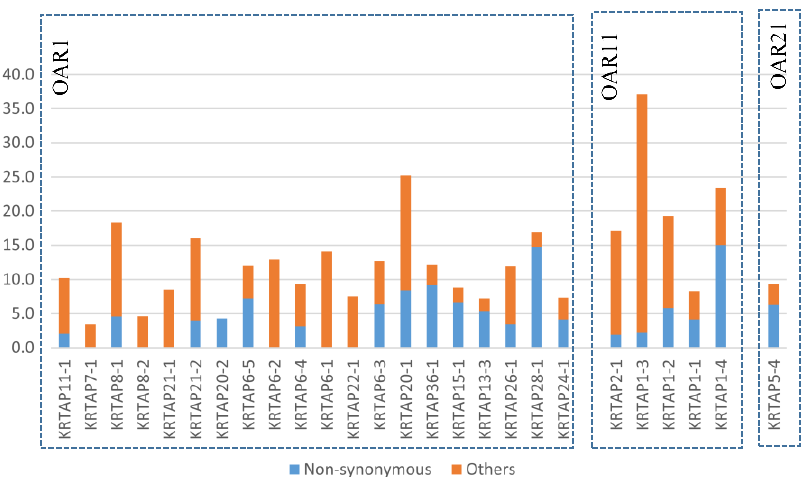
Figure 3. Density of SNPs in selected ovine KRTAP s. The density is expressed as the number of SNPs per kilobase. The order of KRTAP s on the x-axis represents their relative location on the chromosomes 1, 11, and 21. The SNPs are divided into non-synonymous SNPs (in blue) and others (including synonymous SNPs in the coding region and SNPs in the flanking regions).